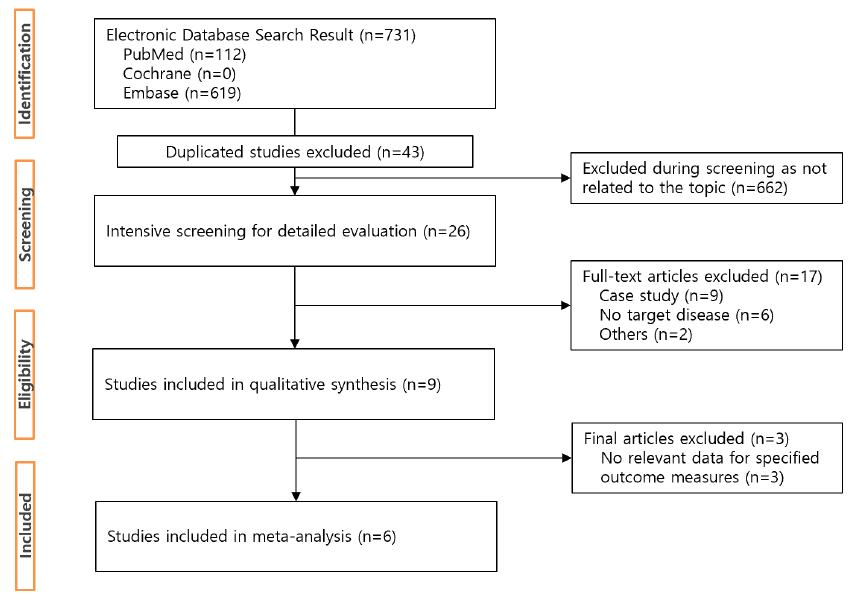
Figure 1. Flowchart of study selection process.